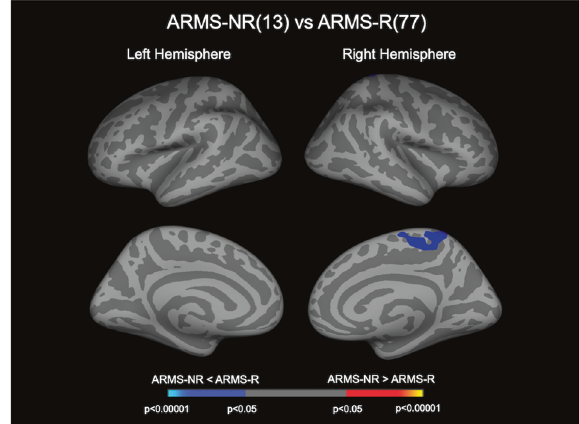
Fig. 1 Clusters showing differences in CT between ARMS individuals and HC. Cortical statistical maps displaying altered CT in individuals with ARMS compared with HC. The maps are shown for the right and left hemispheres in lateral and medial views, respectively. The horizontal bar shows p values corrected for multiple comparisons. ARMS at-risk mental state, CT cortical thickness, HC healthy control.